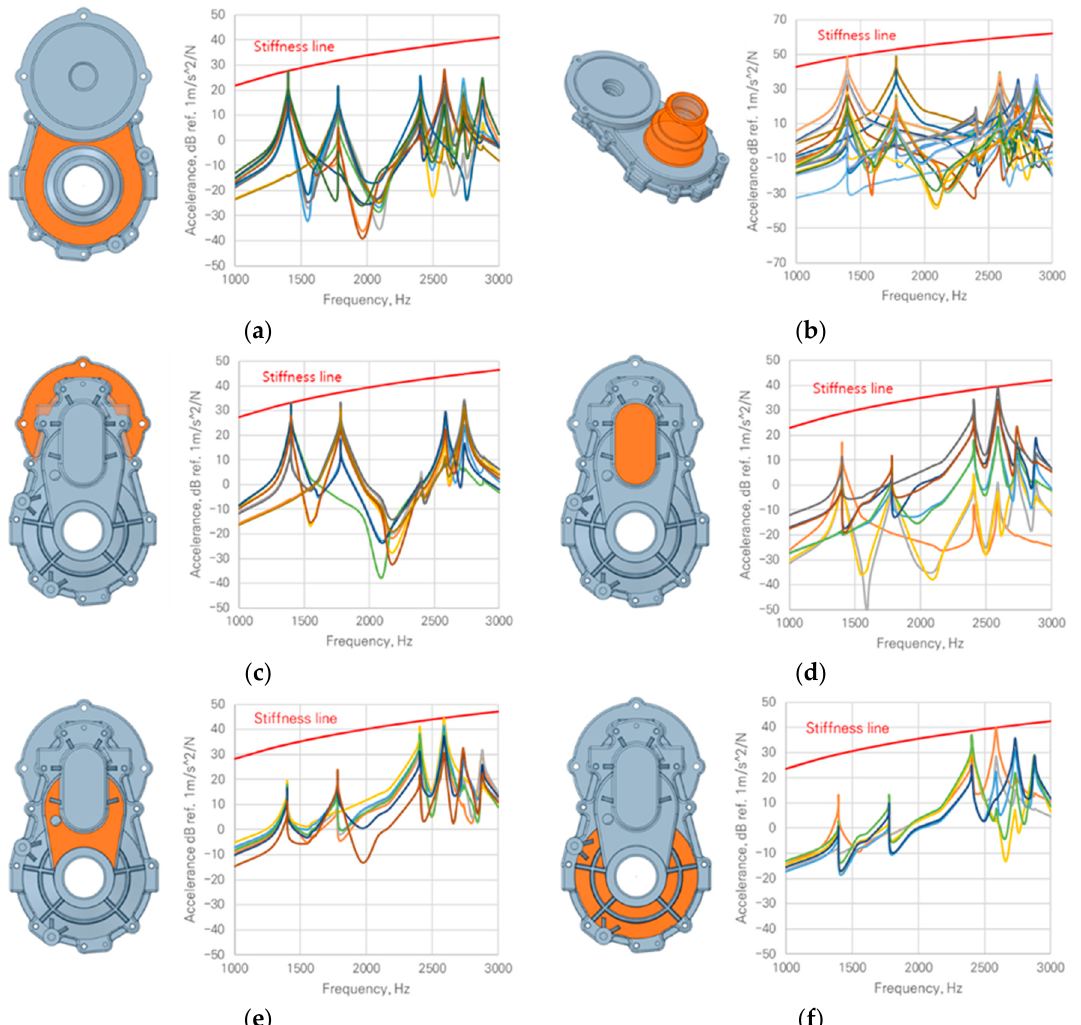
Figure 9. Results of the local stiffness evaluation. ( a ) Part 1; ( b ) Part 2; ( c ) Part 3; ( d ) Part 4; ( e ) Part 5; ( f ) Part 6. Table 5. Results of the local stiffness evaluation.